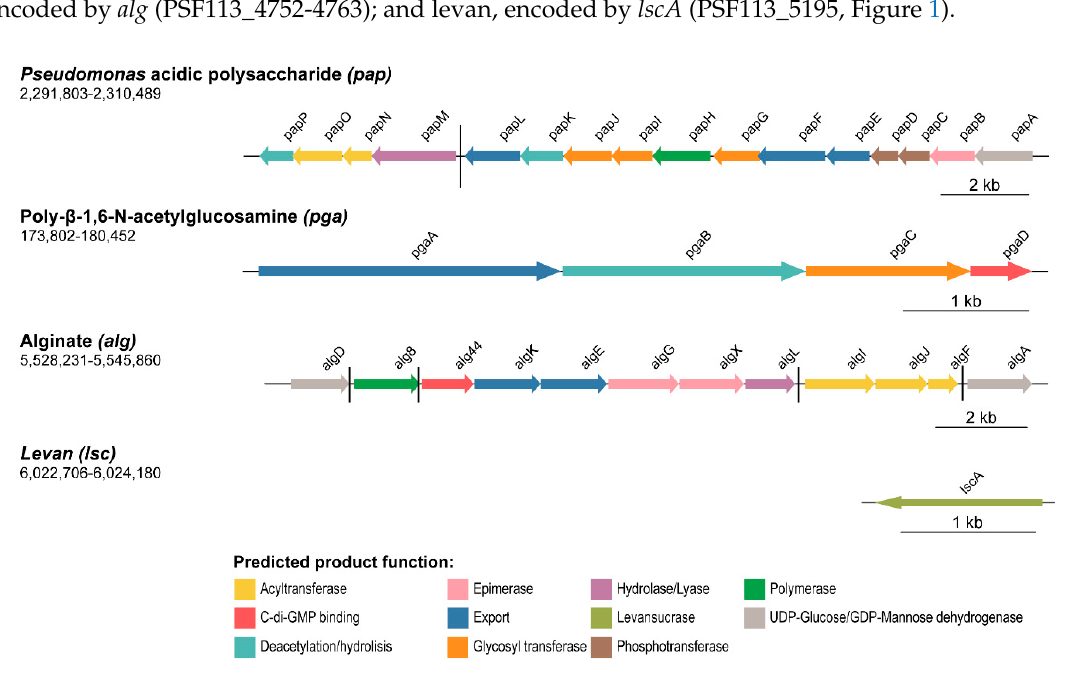
Figure 1. Polysaccharide biosynthetic clusters organization in P. fluorescens F113 genome. Schematic representation of the four genes / gene clusters likely associated with polysaccharide production in F113. Genes are scaled and colored according to the putative function of their encoded proteins, as shown in the legend. Arrow direction indicates the orientation of the gene. The name for each gene is represented above the corresponding arrow. Genomic coordinates are shown below the polysaccharide (gene cluster) name. Black horizontal bars depict different transcriptional regulatory units.